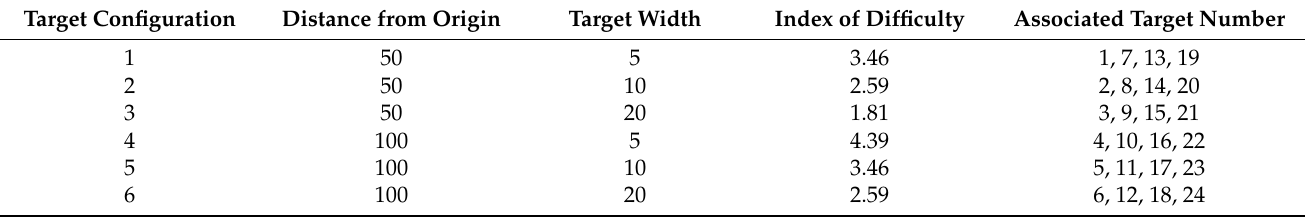
Table 1. Target configurations with associated difficulties and targets